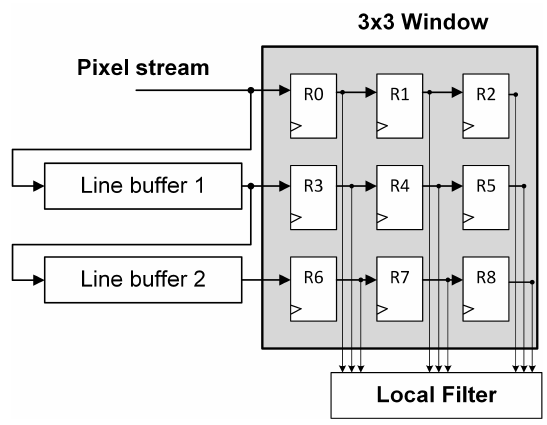
Figure 3. Line buffer pipeline in parallel with